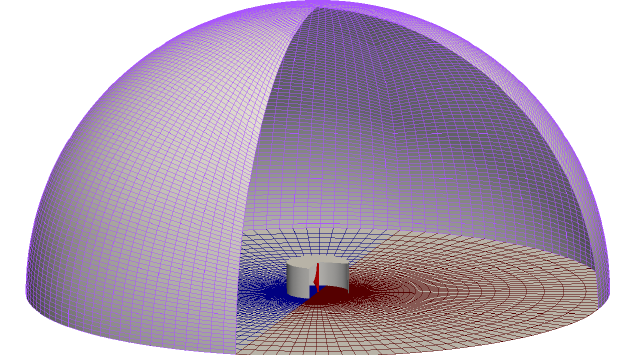
Figure 3. Schematic representation of the computational domain. The inner cylinder represents the arbitrary mesh interface.